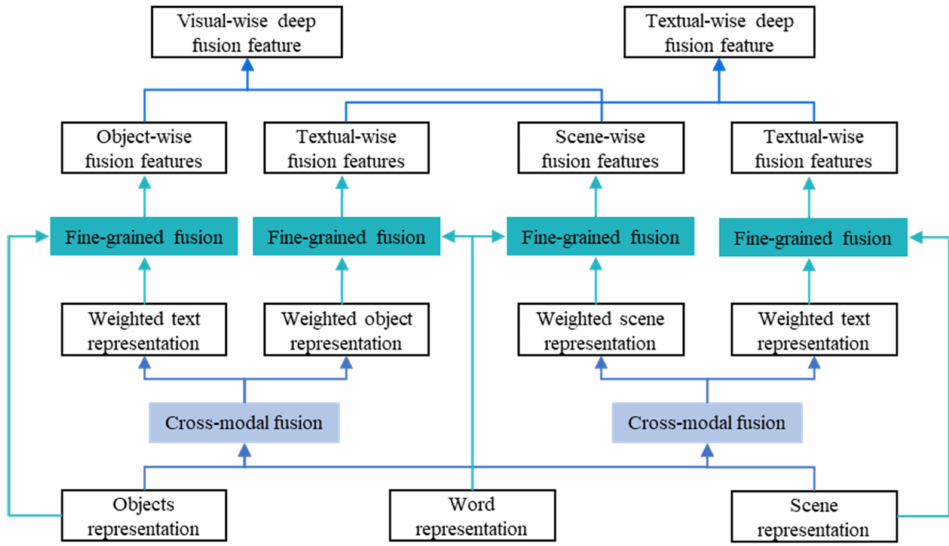
Figure 3. The framework of local fusion